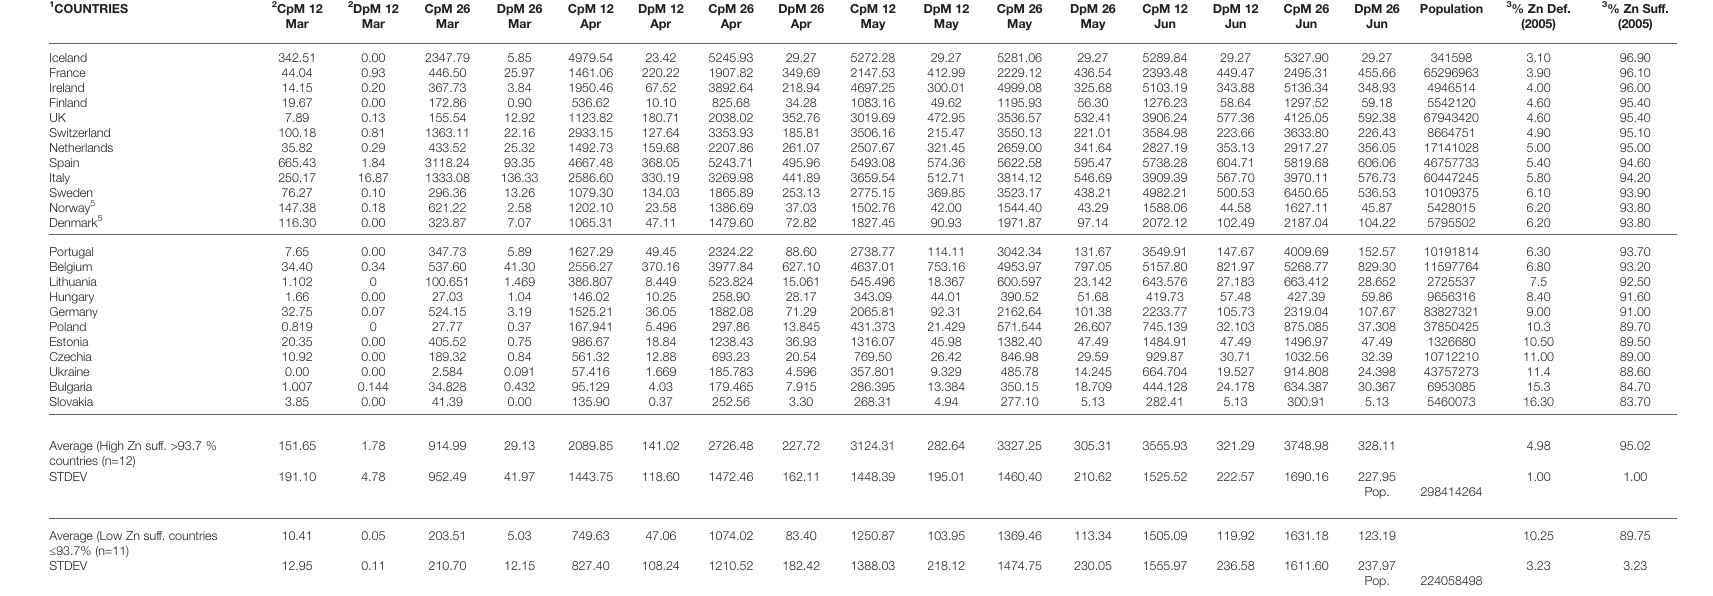
TABLE 1 | COVID-19 incidences and mortality in socially similar European